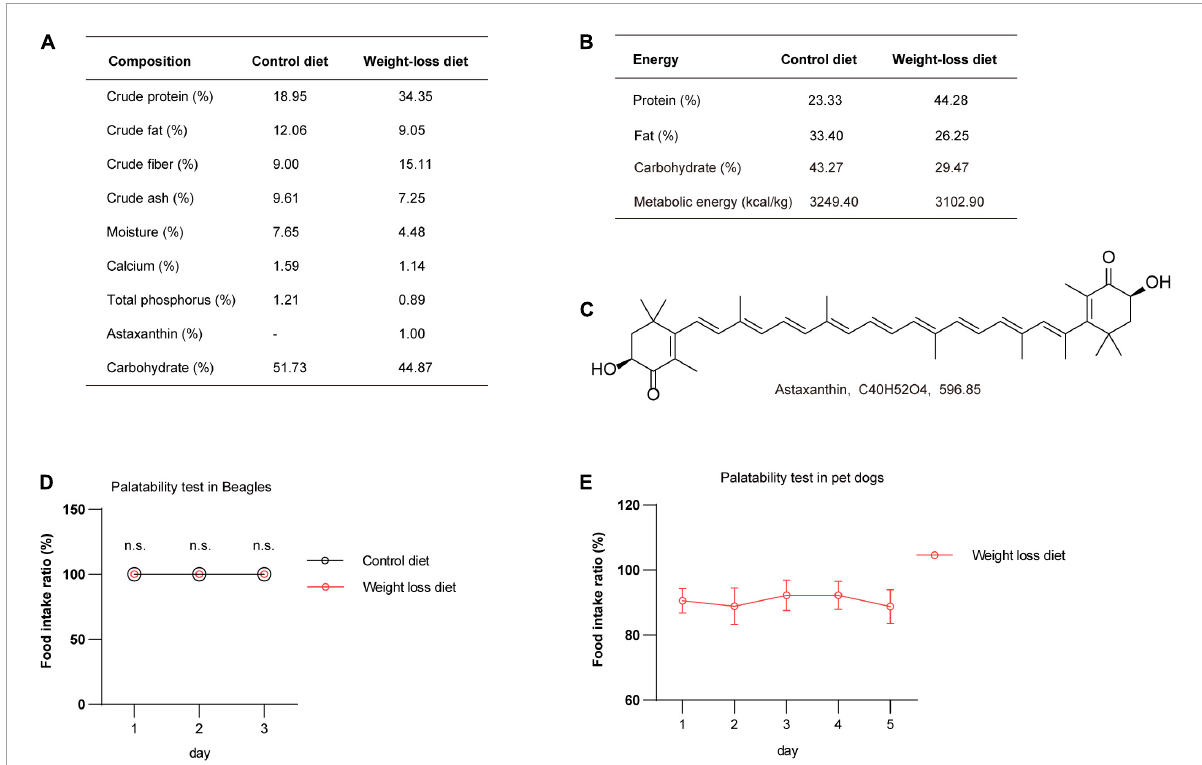
FIGURE2 The nutritional composition of the weight-loss diet and food palatability evaluation. (A,B) The nutritional composition (A) and energy supply ratio (B) of the weight-loss diet and control diet. (C) The chemical structure of the astaxanthin addictive ingredient. (D) The palatability testing analysis in beagles fed a weight-loss diet and control diet in the indicated days. n = 5 beagles/group. (E) The palatability testing analysis in pet dogs fed a weight-loss diet in the indicated days. n = 9 pet dogs. The data in panels (D,E) are presented as the means ± SEMs and were analyzed by Student’s two-tailed t -test. n.s., not